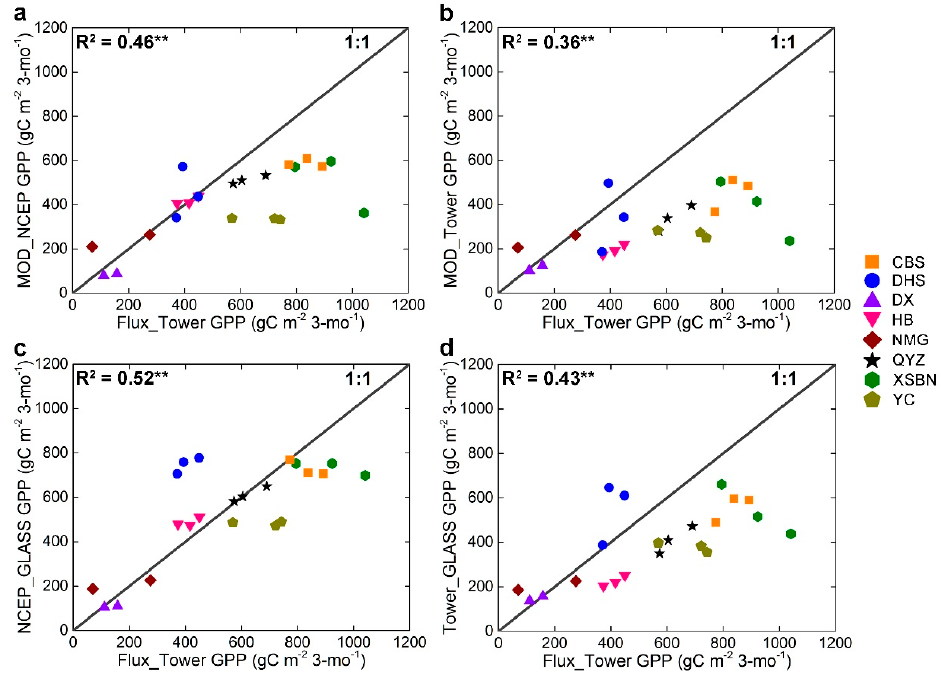
Figure 5. Comparisons of Flux_Tower GPP for summer (June–August) with: ( a ) MOD_NCEP GPP; ( b ) MOD_Tower GPP; ( c ) NCEP_GLASS GPP; and ( d ) Tower_GLASS GPP. Significance levels: ** p < 0.01.